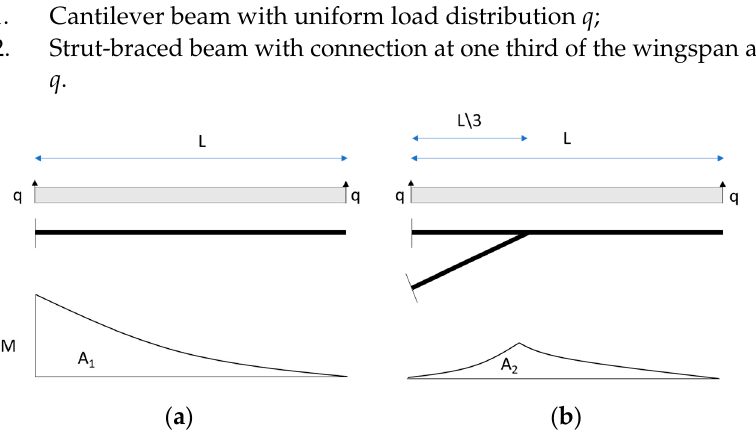
Figure 38. Comparison of beam models: ( a ) cantilever beam; ( b ) strut-braced